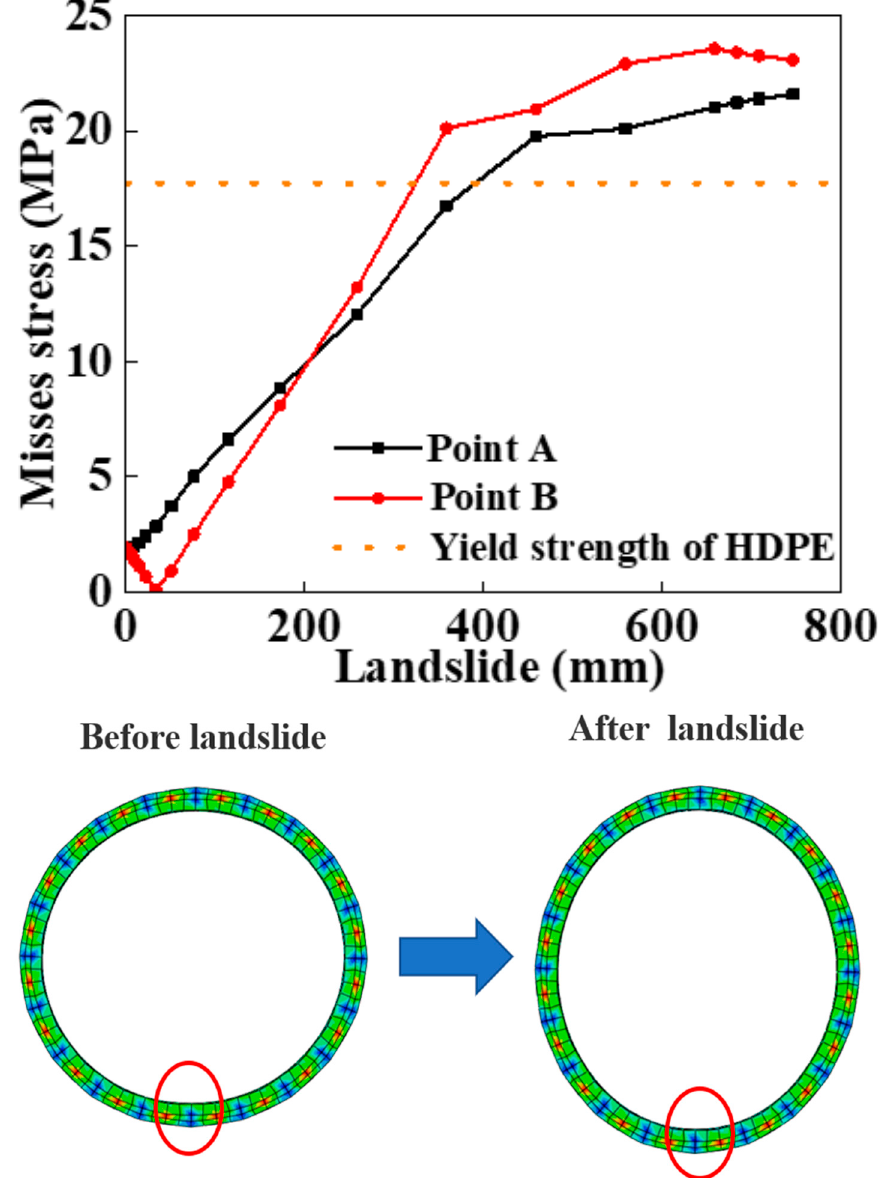
Figure 13. Variation in Mises stress at points A and B on symmetrical surface with the landslide.